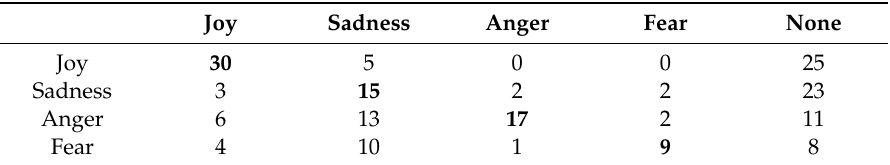
Table 5. Confusion matrix for emotion